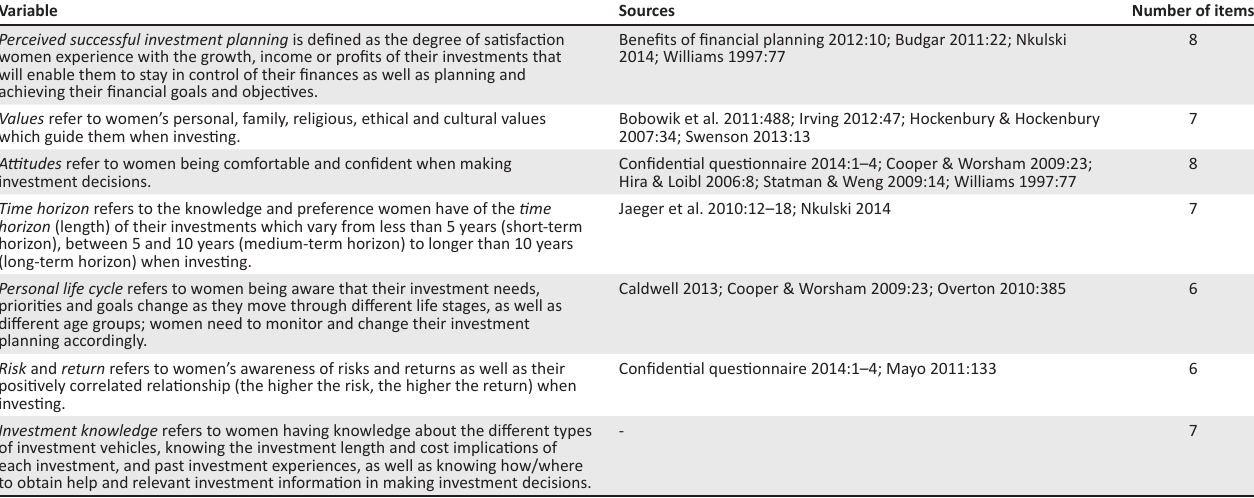
TABLE 1: Operationalisation and sources of variables. Variable Sources Number of